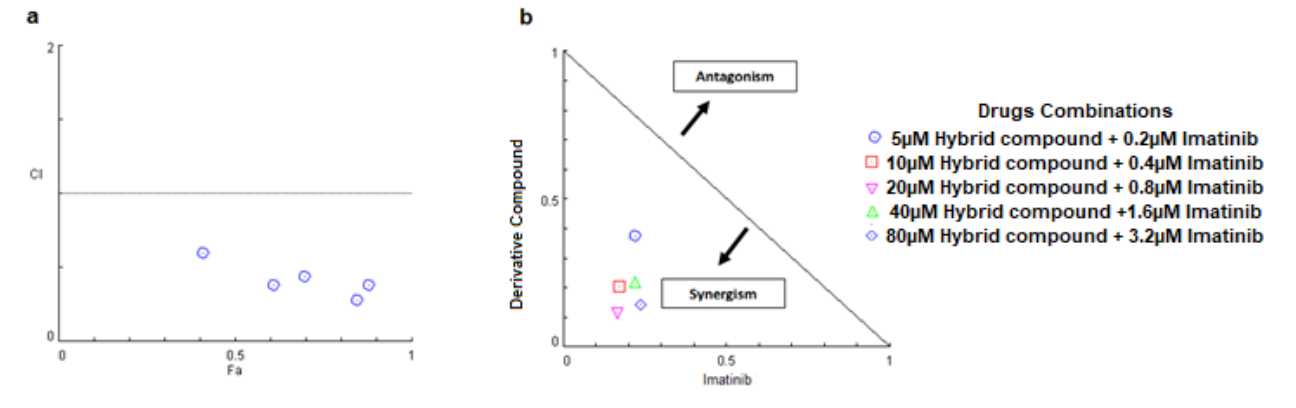
Figure 2. The combination of the hybrid compound with imatinib synergistically inhibited the growth of the K-562 cell line after 48 h treatment. ( a ) The CI values were calculated according to the Chou–Talalay method by CompuSyn software and plotted with the percent of cell growth inhibition as the fraction affected (Fa) cells. ( b ) Normalized isobologram for the combination. The symbols represent different combination ratios. Points that fall below the line are synergistic, above the line are antagonistic and on the line are additive. Table 1. Hybrid compound and imatinib concentrations used in the different combinations evaluated and their respective combination index.